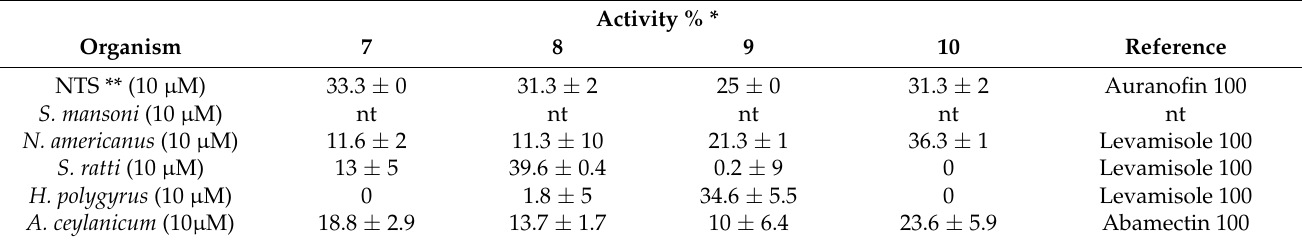
Table 3. In vitro anthelmintic activity of prenyl alcohols 7 – 10 against parasitic helminths. Activity %